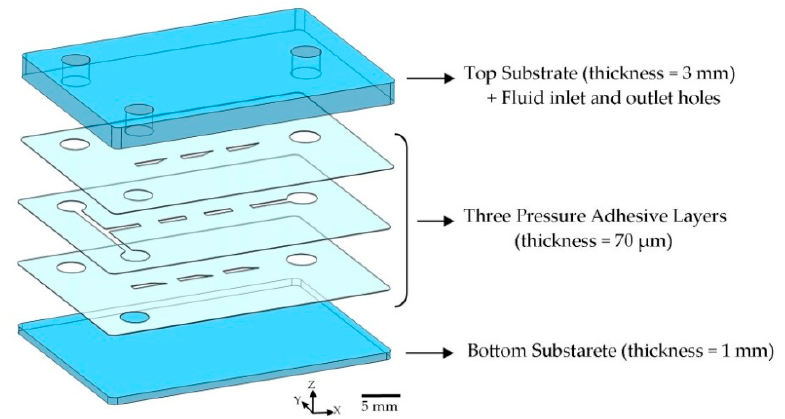
Figure 2. Explosive view of the fabrication method. Three patterned pressure sensitive adhesive (PSA) layers are sandwiched between two cut PMMA substrates shaping the microfluidic device (type A). Three PSA layers built the 3D micromixer geometry, as illustrated in Figure 1. Inlet and outlet holes were suited on the upper substrate and three adhesive layers to allow fluids to enter the micromixer.